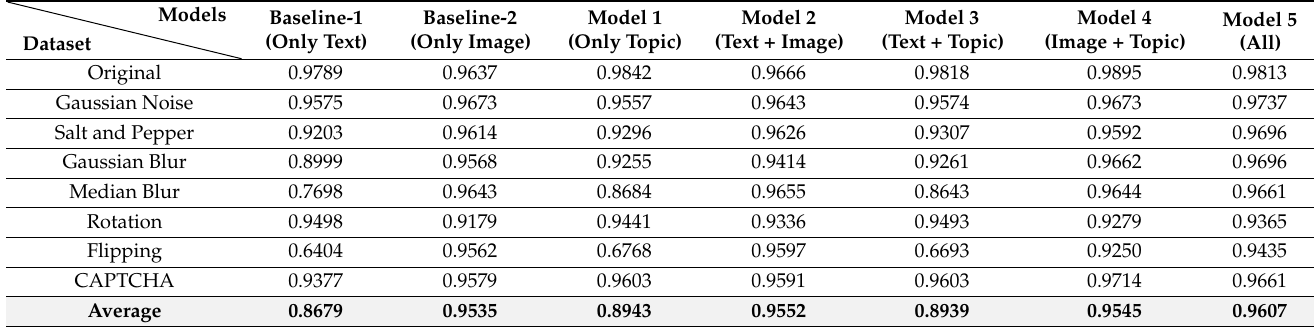
Table 12. Performance of spam image classification model with OCR evasion